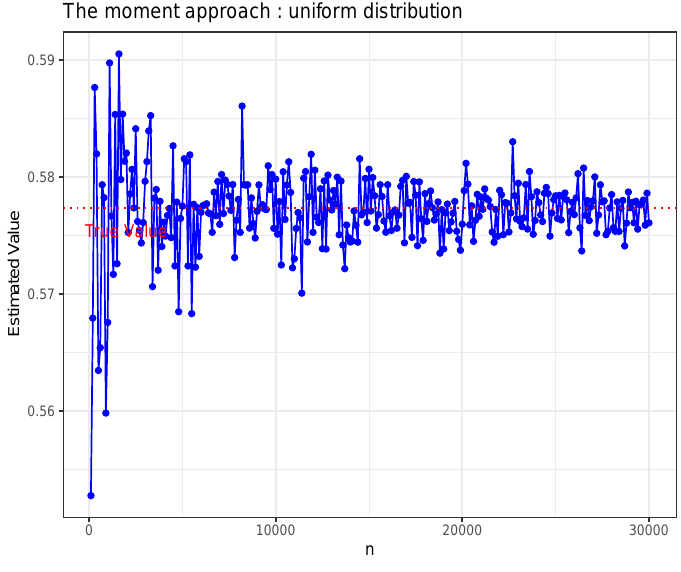
Figure 3. Uniform on [ − 1,1 ] .